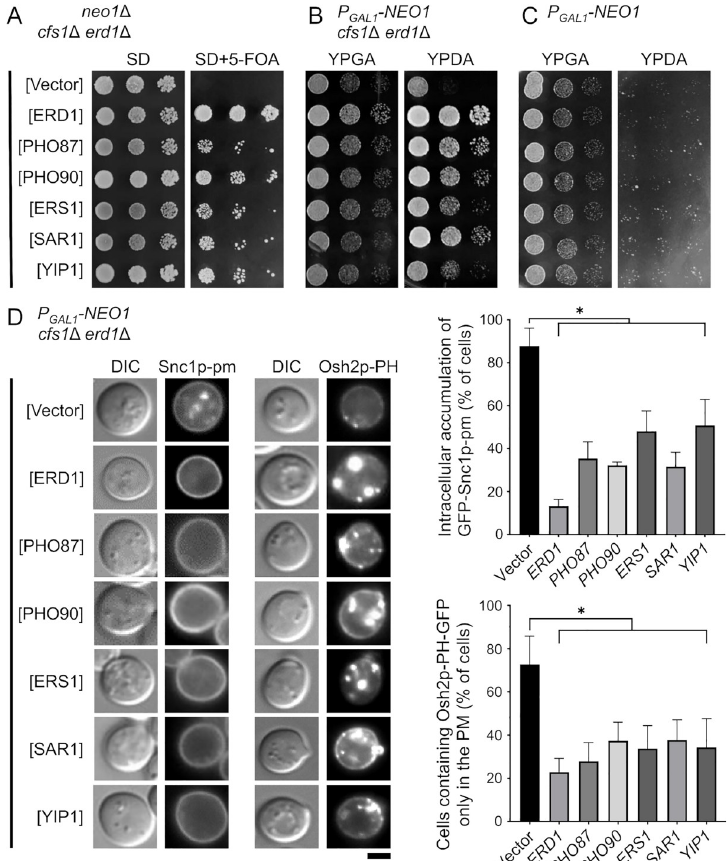
Fig 4. Isolation of multicopy suppressors in the neo1 Δ cfs1 Δ erd1 Δ mutant. (A) Suppression of the growth defects of the neo1 Δ cfs1 Δ erd1 Δ mutant. A spot assay for growth was performed as in Fig 1B; 8- μ l drops of 4-fold serial dilutions were spotted onto SD-L and SD-L+5-fluoroorotic acid (FOA) plates and then incubated at 30˚C for 4 d. Only cells that lost the plasmid harboring the NEO1 gene grew on the 5-FOA medium. The strain used was the neo1 Δ cfs1 Δ erd1 Δ mutant with YCplac33- NEO1 (pKT1470) (YKT2173). This strain was transformed with YEplac181(Vector), pKT2197 (ERD1), pKT2198(PHO87), pKT2199(PHO90), pKT2200(ERS1), pKT2201(SAR1), and pKT2202(YIP1). (B) Suppression of the growth defects of the Neo1p-depleted cfs1 Δ erd1 Δ mutant. A spot assay was performed as in (A), except that 4- μ l drops were spotted onto YPGA (galactose) and YPDA (glucose) plates and then incubated at 30˚C for 1.5 d. The strain used was the P GAL1 - NEO1 cfs1 Δ erd1 Δ mutant (YKT2174). (C) Suppression of the growth defects of the Neo1p-depleted mutant. A spot assay was performed as in (B). The strain used was the P GAL1 - NEO1 mutant (YKT2134). (D) Suppression of the intracellular accumulation of GFP-Snc1p-pm and mislocalization of Osh2p- PH-GFP in the Neo1p-depleted cfs1 Δ erd1 Δ mutant. Cells were cultured in YPDA at 30˚C for 20 h, followed by - NEO1 cfs1 Δ erd1 Δ mutant with either GFP-Snc1p-pm microscopic observation. The strain used was the P GAL1 (YKT2174) or Osh2p-PH-GFP (YKT2162). Each strain was transformed with the plasmids in (A). Left panel : Representative cells are shown. Right panels : The percentage of cells with intracellular accumulation of GFP-Snc1p-pm or Osh2p-PH-GFP only in the PM was determined ( n = 200), and the results are expressed as the mean ± standard deviation of five independent experiments. Asterisks indicate a significant difference, as determined by the Tukey– Kramer test ( � : p < 0.01). Bar, 5 μ m. DIC, differential interference contrast. Isolation of PHO87 and PHO90 is interesting, as Erd1p is proposed to transport Pi from the lumen of the Golgi to the cytoplasm [20]. Since Pho87p and Pho90p are low-affinity Pi trans- porters at the PM, our results suggest that the synthetic lethality of the neo1 Δ cfs1 Δ erd1 Δ